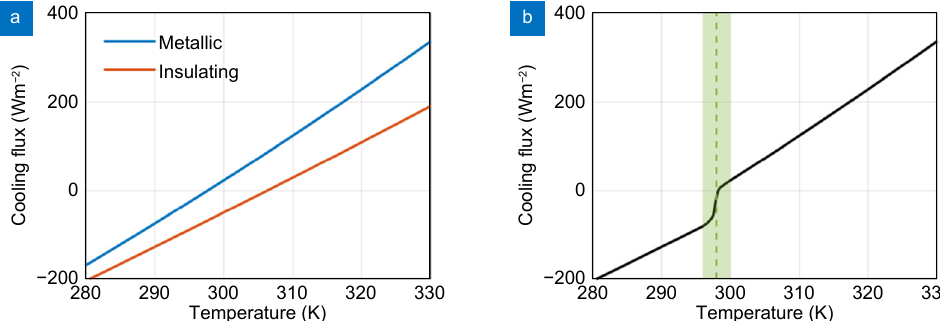
Fig. 4 | Cooling flux of the radiative cooler under normal incidence of solar energy when T amb = 303 K. ( a , b ) Cooling flux when permittiv- ity of VO 2 is assumed to be (a) static and (b) dynamic. Shaded area represents the transition